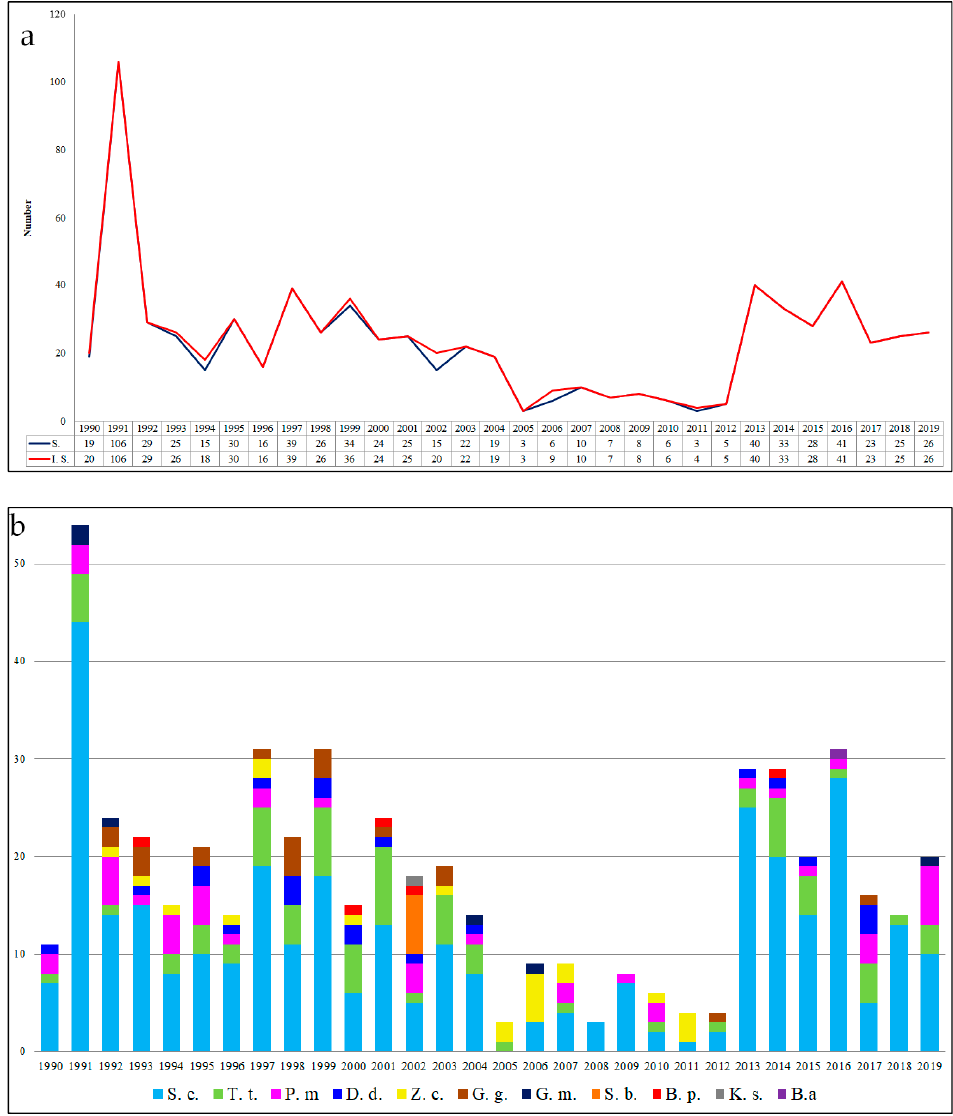
Figure 4. ( a ) Stranding frequency on Sicilian coast (1990–2019); S., Number of stranding events; I. S., number of stranded and entangled individuals; unidentified specimens included. ( b ) Number of stranded and entangled individuals for each species along the Sicilian coast per year (1990–2019). From the most to the less abundant S. c. = Stenella coeruleoalba ; T. t . = Tursiops truncatus ; P. m. = Physeter macrocephalus ; D. d. = Delphinus delphis ; Z. c. = Ziphius cavirostris; G. g. = Grampus griseus ; G. m. = Globicephala melas ; S. b. = Steno bredanensis ; B. p . = Balaenoptera physalus; K. s. = Kogia sima; M. n. = Megaptera novaeangliae ; B. a. = Balaenoptera acutorostrata; unidentified specimens not included.